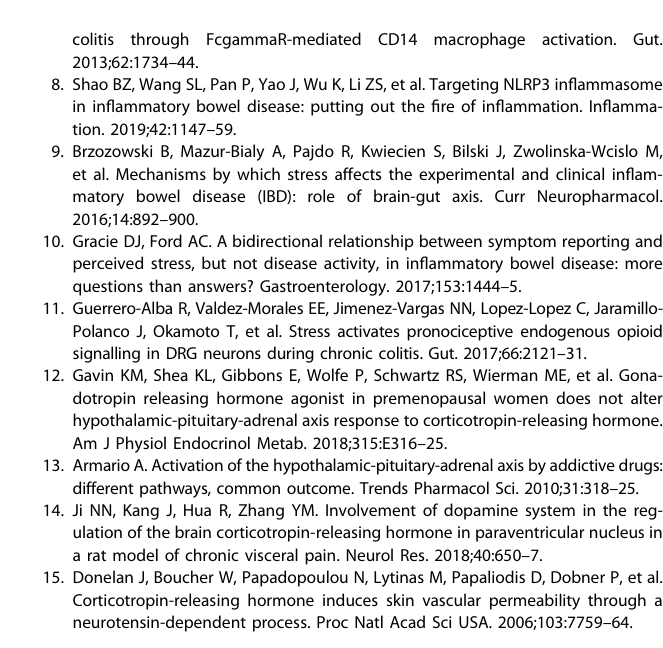
Fig. 8 Chloroquine attenuated the CRH-induced increase in autophagy in BMDMs under the challenge of LPS. BMDMs were treated with LPS (100 ng/mL), CRH (10 − 8 M), and/or chloroquine (10 μ M). Representative images of mRFP-GFP-LC3-transfected BMDMs were then assessed by immuno fl uorescence. A , B In comparison with the LPS + vehicle group, mice in the LPS + CRH group exhibited a signi fi cant increase in Beclin-1 and the LC3-II/I ratio, but a decrease in p62. These effects of CRH were blocked by chloroquine administration. ( n = 5 per group). ** P < 0.01 vs. the control group; ## P < 0.01 vs. the LPS + vehicle group; $$ P < 0.01 vs. the LPS + CRH group. C While CRH signi fi cantly elevated autophagy levels under the challenge of LPS, chloroquine administration attenuated the effects of CRH. D Quantitative analysis of the number of yellow autophagosomes and red autolysosomes. ( n = 6 per group). ** P < 0.01 vs. the control group; ## P < 0.01 vs. the LPS + vehicle group; $$ P < 0.01 vs. the LPS + CRH